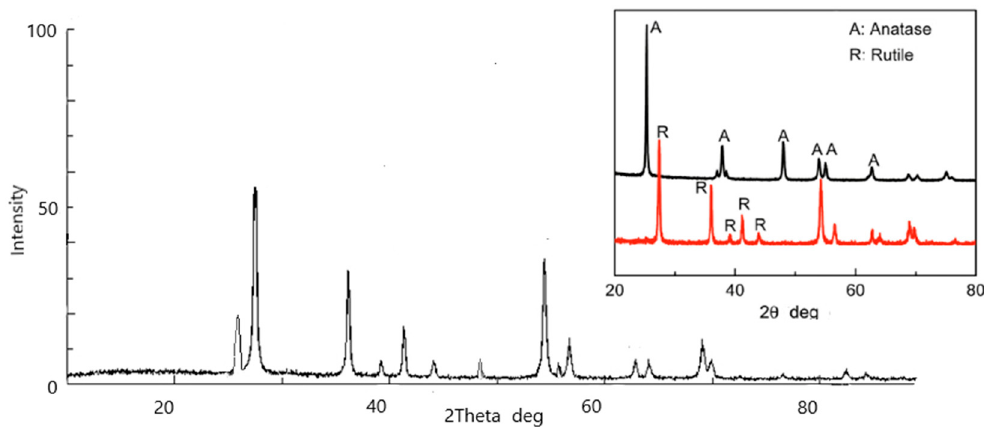
Nanomaterials 2019 , 9 , x FOR PEER REVIEW Figure 1. X-ray diffractogram of TiO2 from the commercial sunscreen with an average particle size of 43 nm (determined by XRD); inner image – XRD of rutile standard (R) and anatase standard (A).